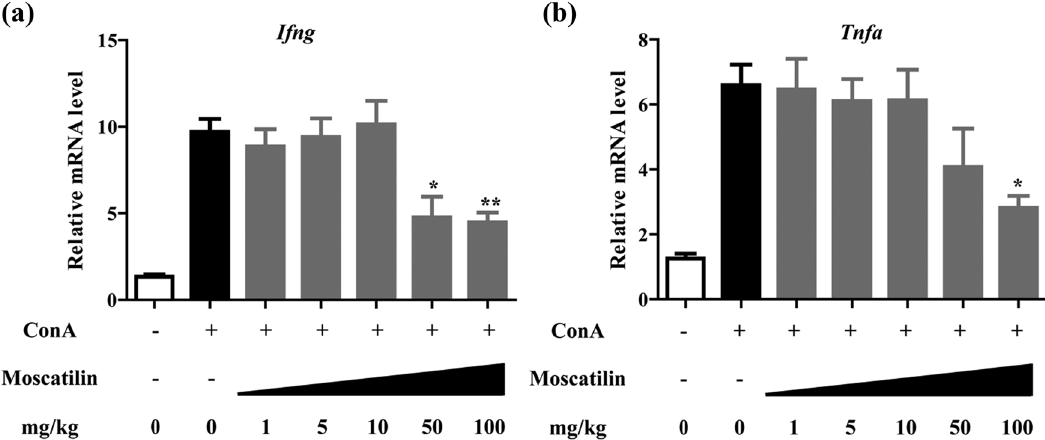
Figure 2: Moscatilin suppresses the hepatic production of IFN - γ and TNF - α . The mRNA expression of Ifng ( a ) and Tnfa ( b ) genes in the liver tissues was detected 24 h after the ConA injection by real - time RT - PCR. Each group contained fi ve tissue samples and * indicated p value less than 0.05, ** indicated p value less than 0.01 compared to the ConA